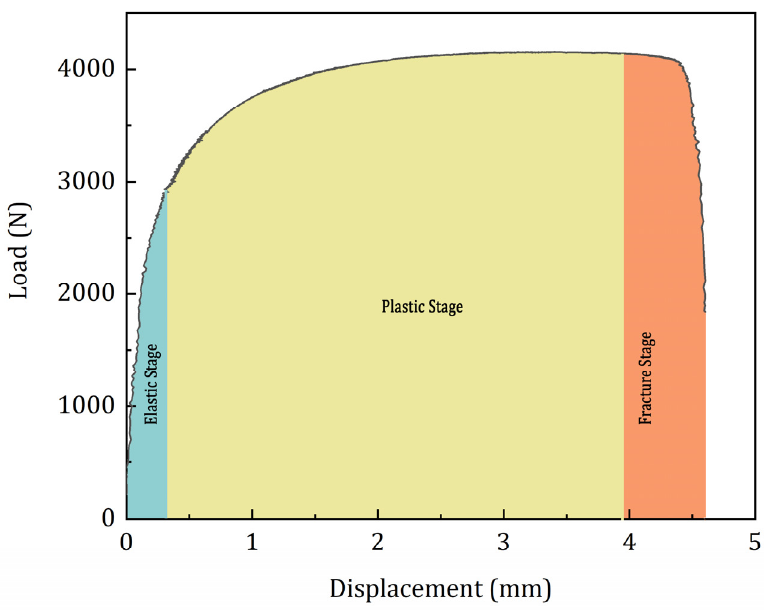
Figure 5. Damage stages considered for the AE analysis.